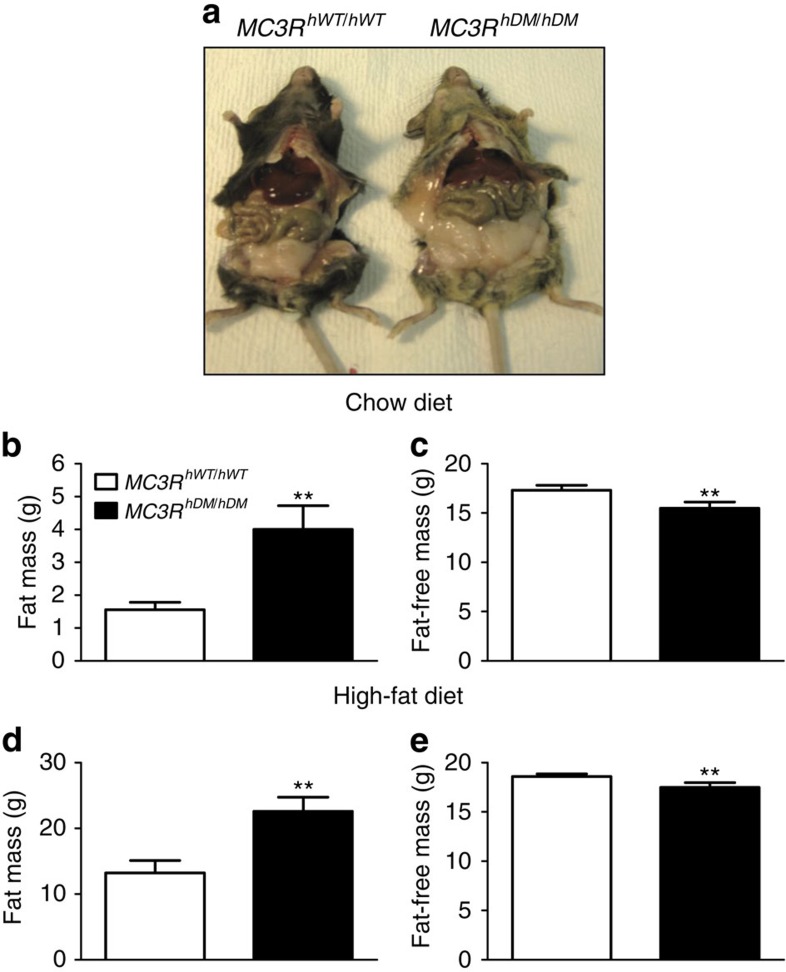
Greater fat mass and reduced fat-free mass in MC3RhDM/hDM mice.(a) Female (5-month old) MC3RhDM/hDM mice had increased adiposity compared with MC3RhWT/hWT. (b,c) Female MC3RhWT/hWT (n=7, open bars) or MC3RhDM/hDM (n=10, closed bars) mice were fed chow diet or (d,e) high-fat diet (MC3RhWT/hWT
n=6; MC3RhDM/hDM
n=9) for 2 months. Body fat mass and fat-free mass were measured by MRI at age 2–3 months and 4–5 months for chow-fed and high-fat-fed mice, respectively. Data are represented as mean±s.e.m. *P<0.05 and **P<0.01 MC3RhDM/hDM versus MC3RhWT/hWT mice. Groups were compared by Student's t-tests (two-tailed) (b–e).